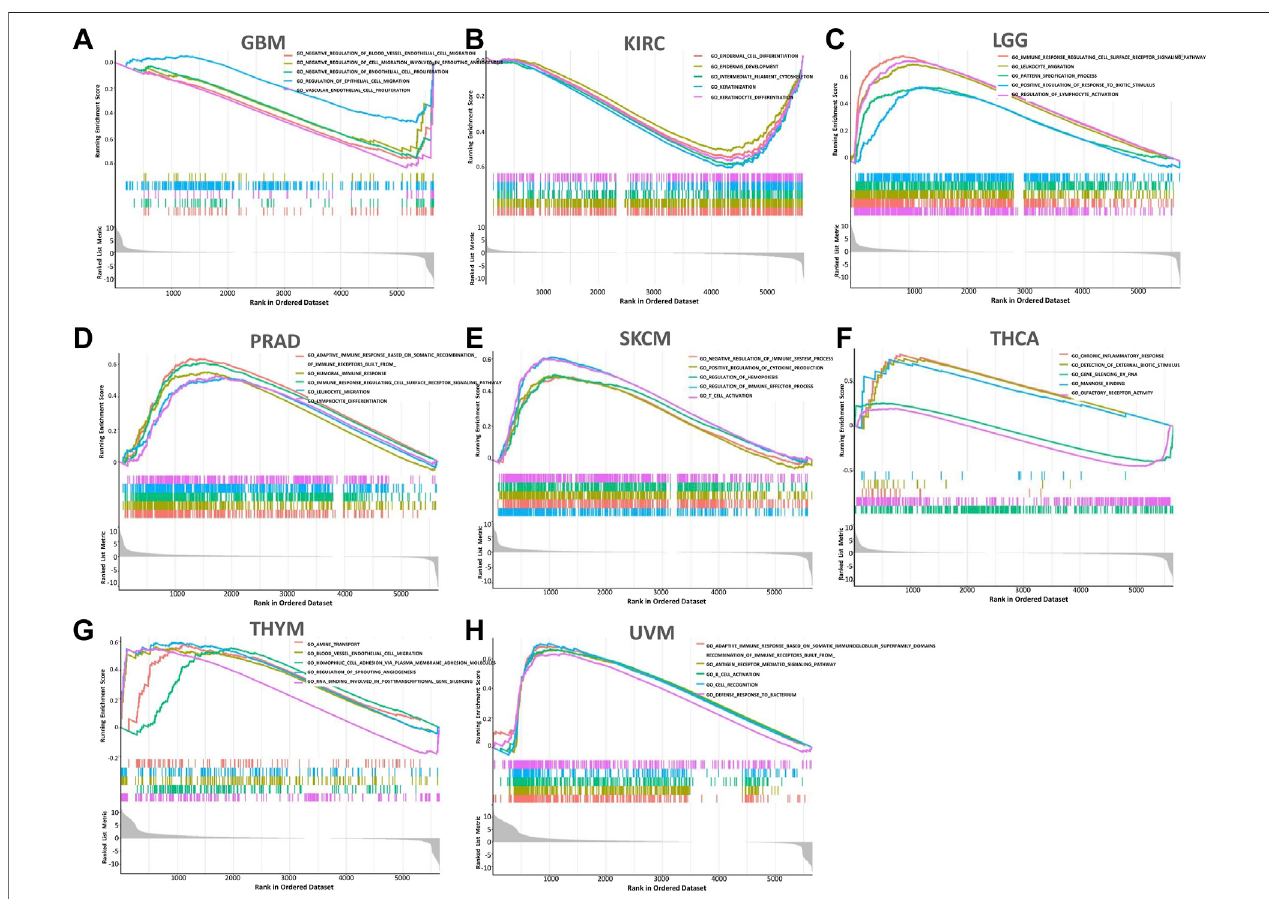
FIGURE 9 | The 5 most relevant signaling pathways of FCGR3A ’ s GSEA in the GO dataset. (A) Glioblastoma multiforme (GBM); (B) Kidney renal clear cell carcinoma(KIRC); (C) brainlowergradeglioma(LGG); (D) Prostateadenocarcinoma(PRAD); (E) Skincutaneousmelanoma (SKCM); (F) Thyroidcarcinoma(THCA); (G) Thymoma (THYM); (H) Uveal melanoma